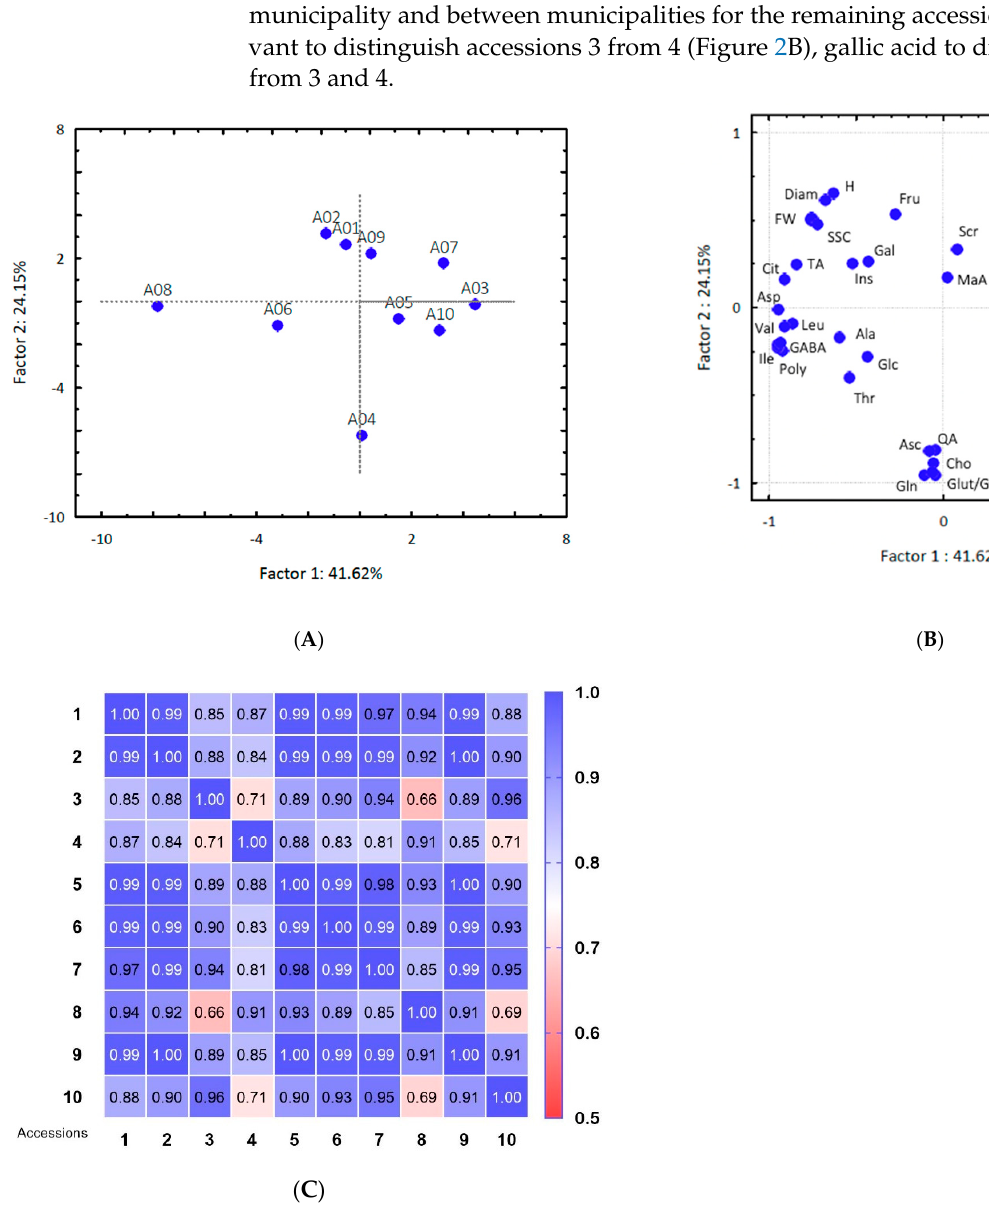
Figure 2. Principal component analysis showed scores ( A ) and loadings ( B ) and correlations (significant at p < 0.05) ( C ) including the parameters analyzed in cambuci pulp analytical and NMR analyses of the ten accessions named 1 – 10 (A01 – A10). SSC: total soluble solids; TA: titratable acidity.; FW: fresh mass; H: height; Diam: diameter; Scr: sucrose, Glu: glucose,